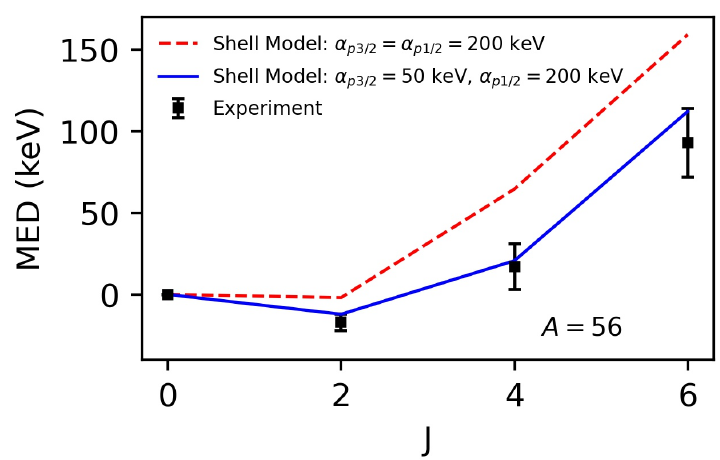
Figure 6. Results from [9]. The experimental MED for the A = 56, T = 2 mirror nuclei compared with the results of shell-model calculations performed with the KB3GR interaction. The model uses the standard parameterisation, but with a varying value of the scaling parameter, α (Equation (3)), used in the determination of the radial contribution to the MED due to the occupation of the p 3 orbital. See text for